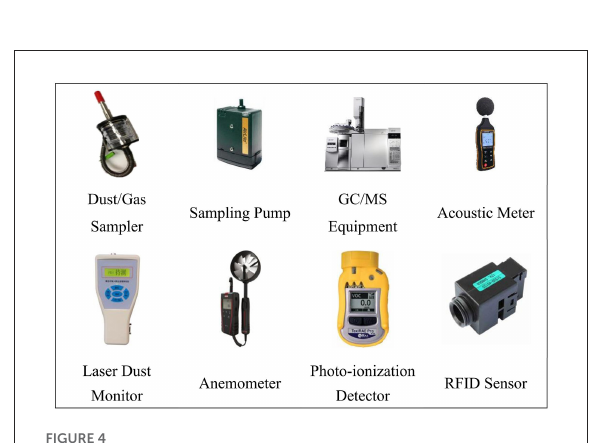
FIGURE4 Main instruments and equipment proposed for